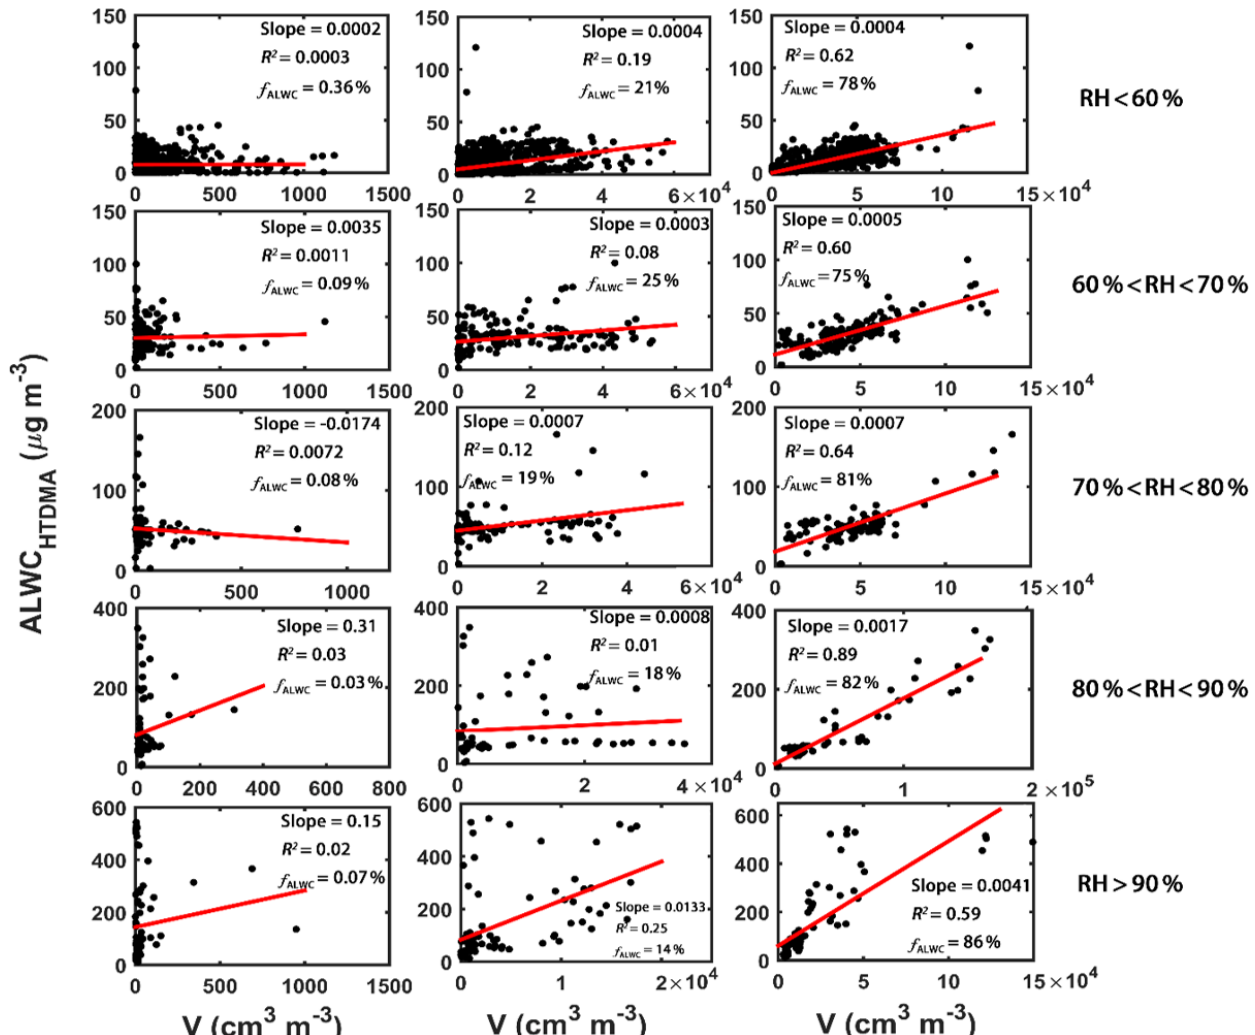
Figure 5. The correlation analysis between ALWC HTDMA and the volume concentration of nucleation mode (left column), Aitken mode (middle column) and accumulation mode (right column) particles under different ambient relative humidity (RH) conditions. The average contribution of each mode particles to ALWC under different ambient RH conditions is denoted by f ALWC . The red lines represent the best-fit lines from linear